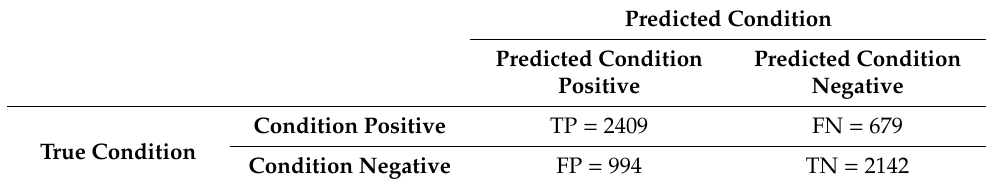
Table 10. Confusion matrix for MLP. (TP: true positive, TN: true negative, FN: false negative, FP: false positive).